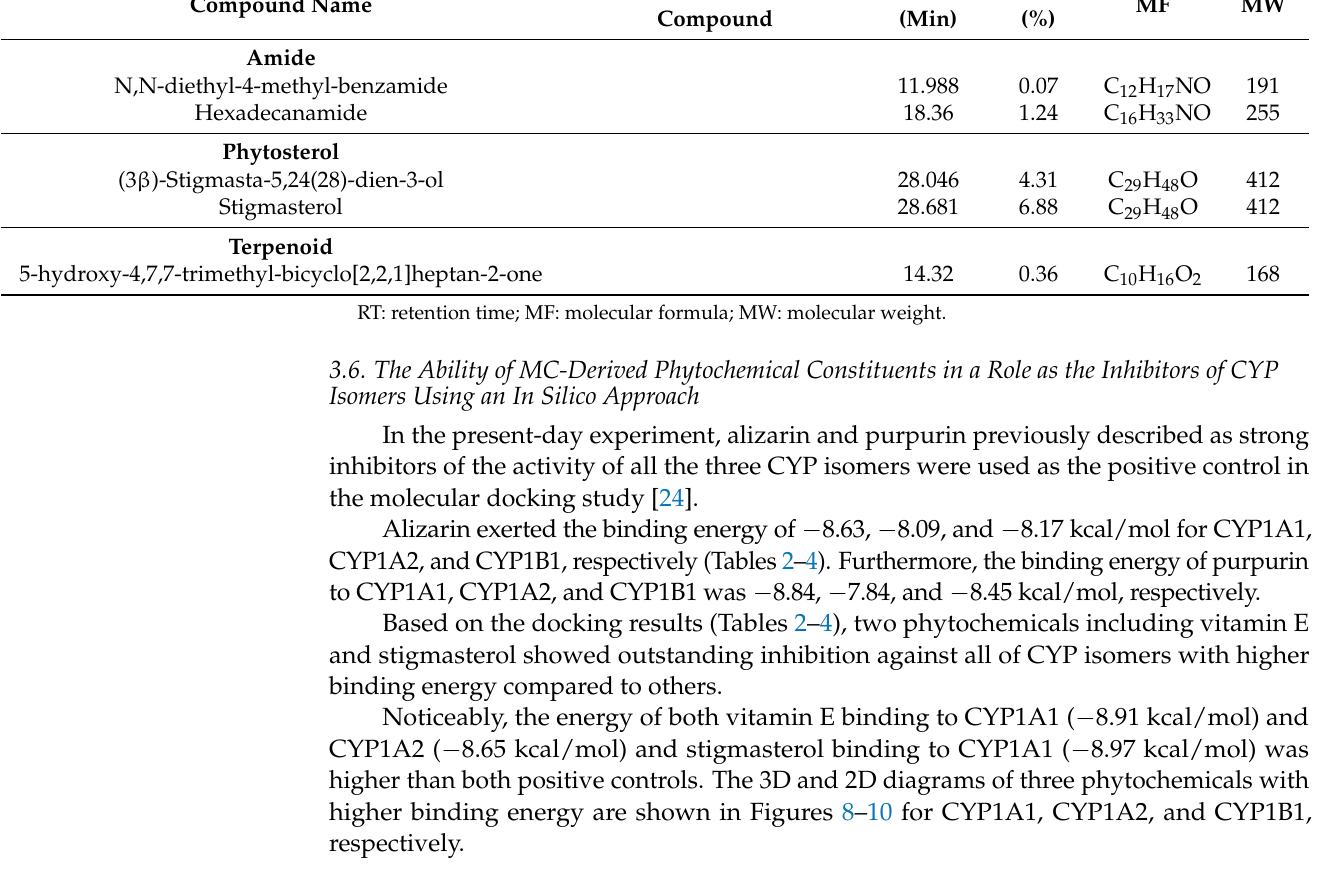
Table 2. Docking results of the phytochemical constituents with 1 CYP1A1 ( 2 PDB ID: 4I8V).